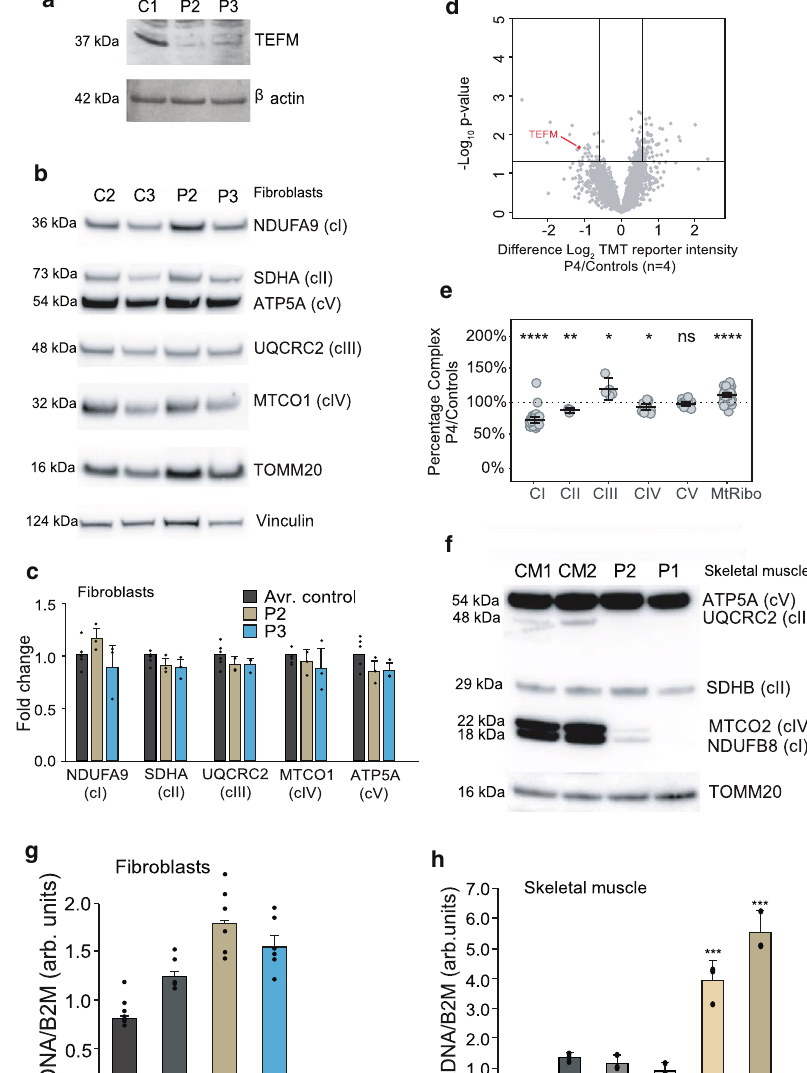
Fig.4|ThelevelsofTEFMandOXPHOScomponentsandmtDNAcopynumber in patient samples. a Western blot detecting the TEFM protein in human dermal fi broblasts from patients 2 (P2) and 3 (P3). β -actin was used as a loading control. b RepresentativeexampleofwesternblotanalysisofNDUFB9(complexI,cI),SDHA (complex II, cII), UQCRC2 (complex III, cIII), MTCO1 (complex IV, cIV), and ATP5A (complex V, cV) for fi broblasts from patients 2 (P2) and 3 (P3) and wild-type con- trols (C2 and C3). TOMM20 and Vinculin were used as loading controls. c Quanti fi cation of 3 western blot experiments as per (b). Data were statistically analyzed by two- tailed Student ’ s t -test. Error bars = mean ± 1 standard deviation, n =3. d Volcano plot comparing whole-cell protein abundances for proteins quanti fi ed in P4 fi broblasts ( n =2 technical) relative to control fi broblasts ( n =4 biological). TEFM protein is highlighted in red. Signi fi cance lines were plotted at p -value <0.05 and log 2 difference 0.585 (1.5-fold change equivalent) from two- sample t -test analysis. e Relative complex abundance of quantitative proteomics data plotted as a ratio of each subunit in TEFM/controls and represented as a percentage. The middle bar represents the mean value for the subunits in each